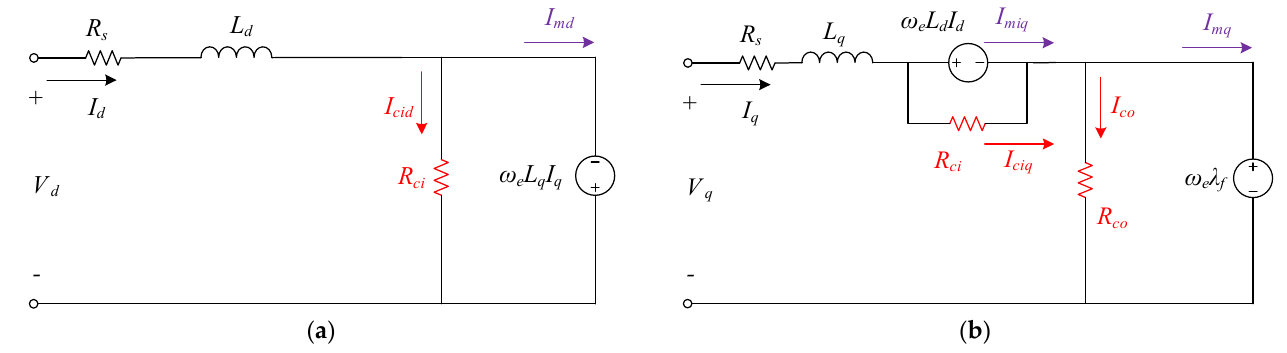
I Figure 16. Proposed per-phase ECM of PMSM with accurate core loss prediction. According to the proposed per-phase ECM, the following mathematical equations are obtained: